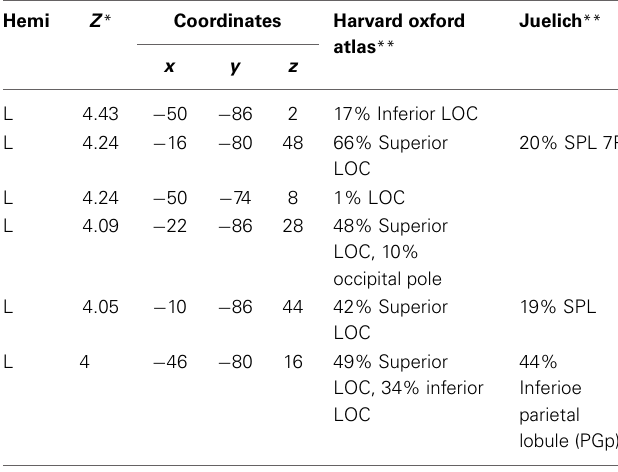
Table 2 | Periphery (11–15) vs. central (2–7): deaf